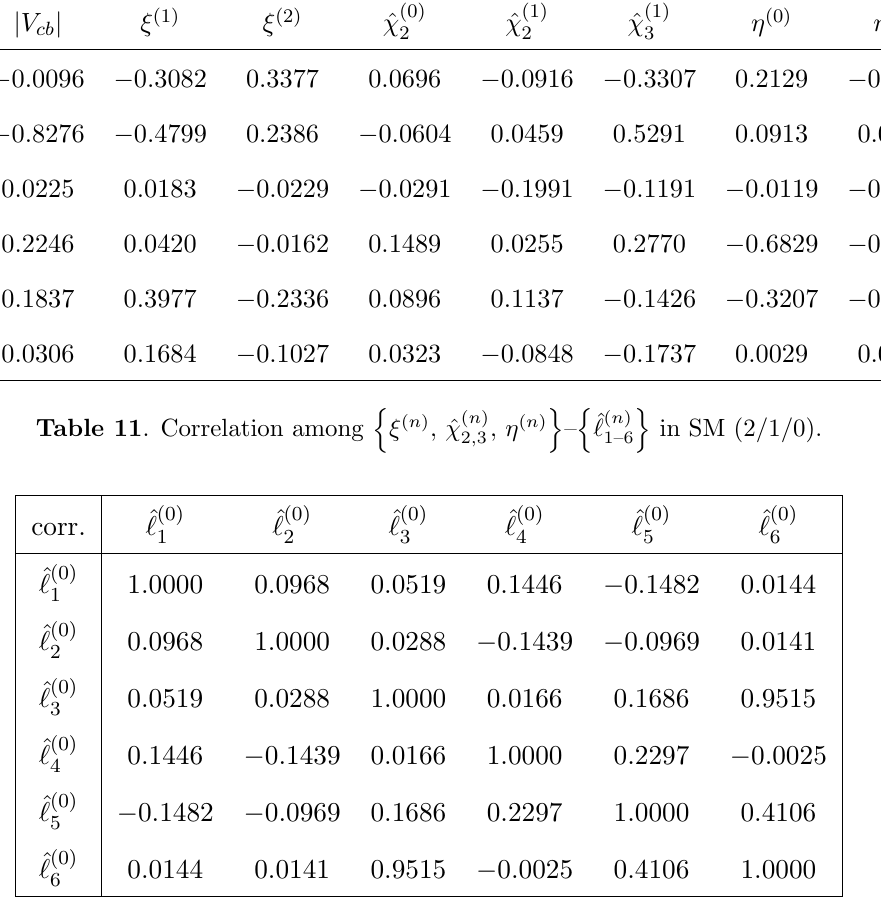
Table 12 . Correlation among